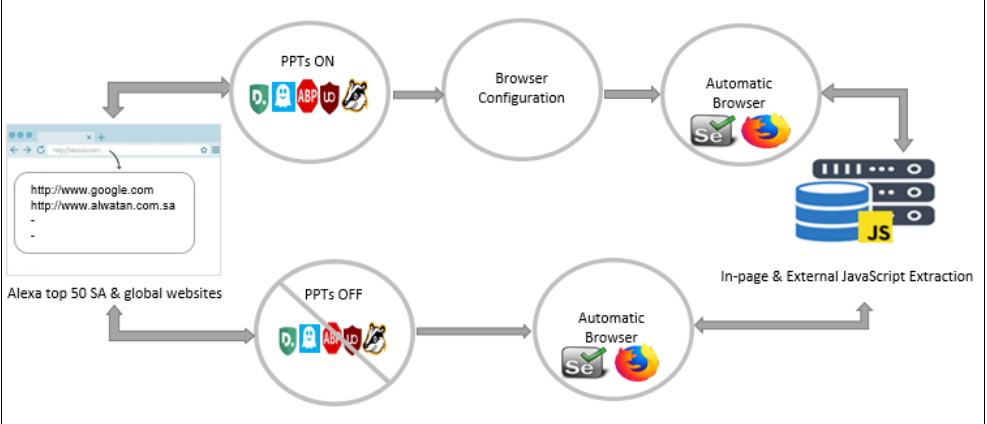
Figure 3. Measurement framework for the privacy protection